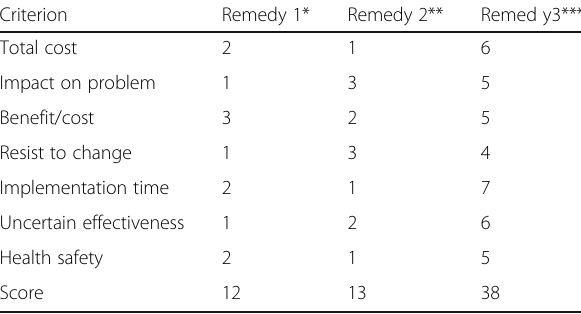
Table 4 Improvement solutions